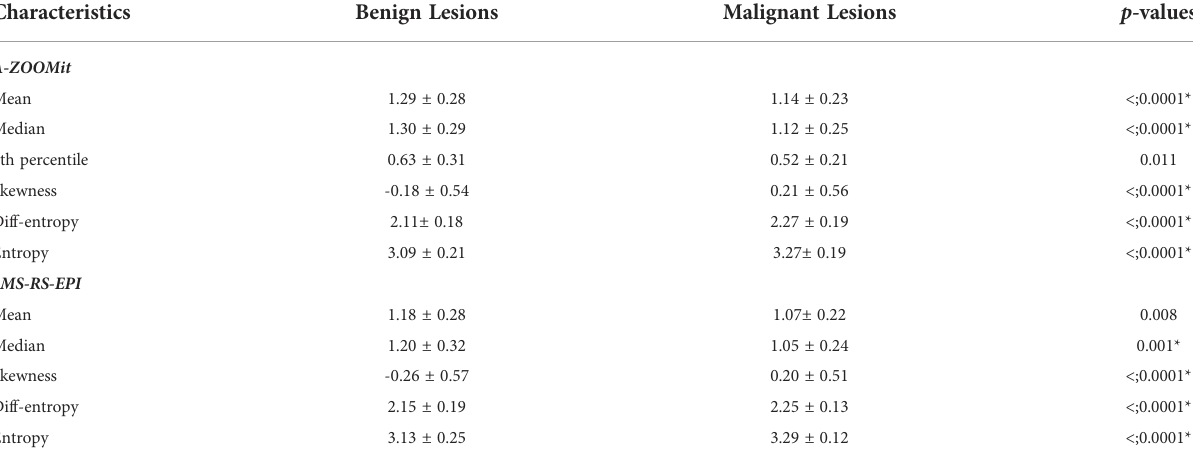
TABLE 3 Histogram and texture analysis of apparent diffusion coef fi cient values based on SMS-RS-EPI and A-ZOOMit between malignant and benign breast lesions. Characteristics